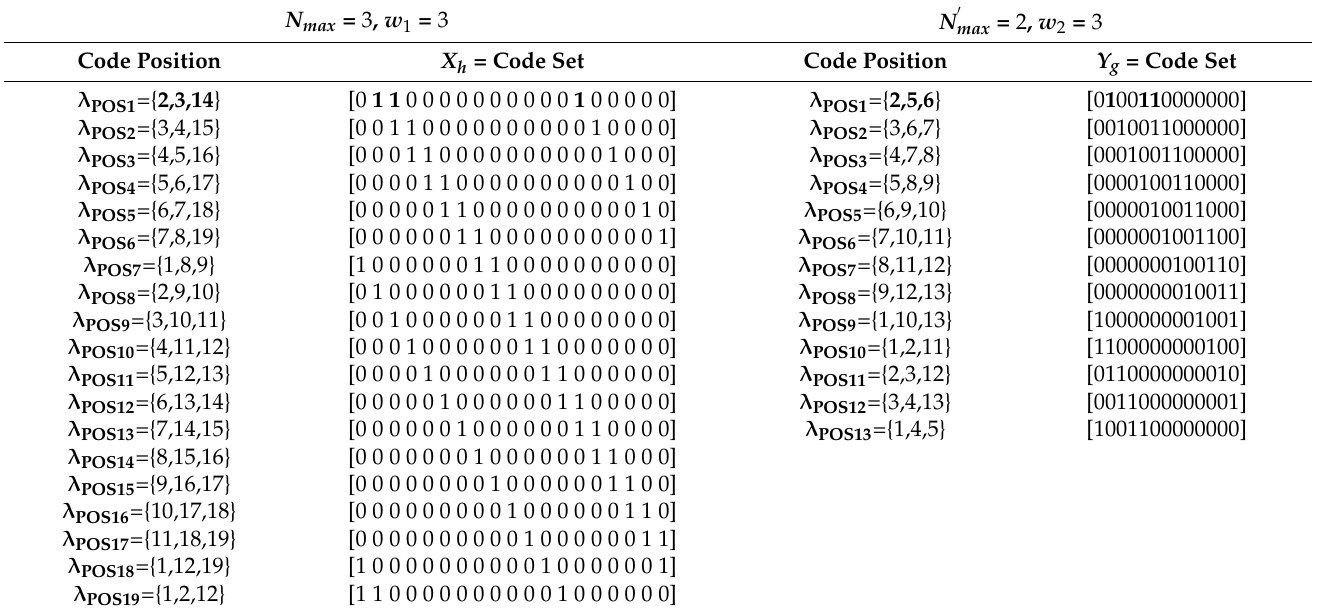
Table 1. An example of 1D balanced incomplete block design (BIBD) code sets X ( N max = 3; w 1 = 3 ) and Y ( N (cid:48) max = 2; w 2 = 3). N max = 3 , w 1 = 3 N (cid:48) max = 2 , w 2 =